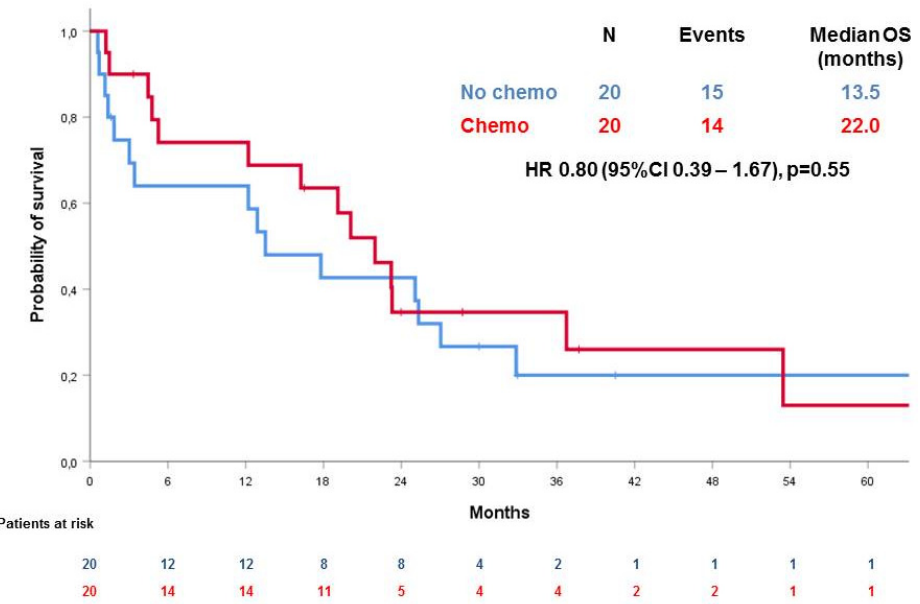
Figure 3. Overall survival (OS) according to post-operatory chemotherapy.